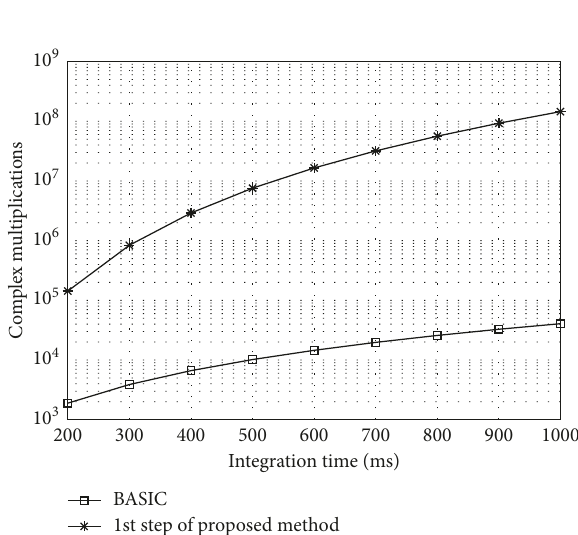
Figure 3: Complex multiplications comparison for coarse MF estimation methods.